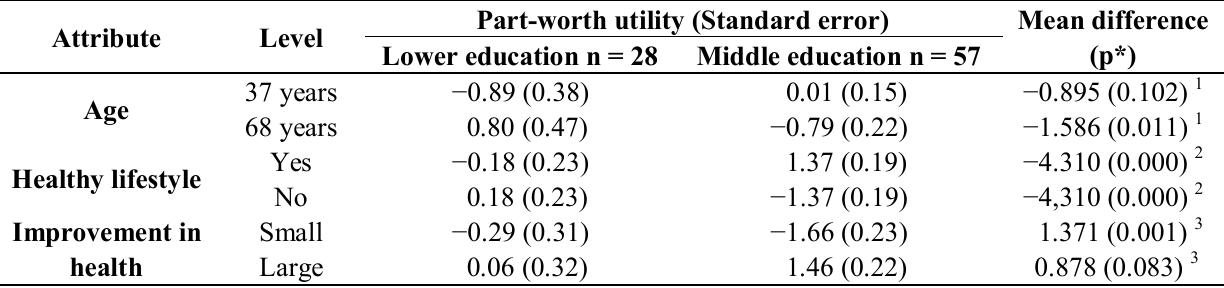
Table 6. Differences between part-worth utilities estimated for participants with lower and middle education.